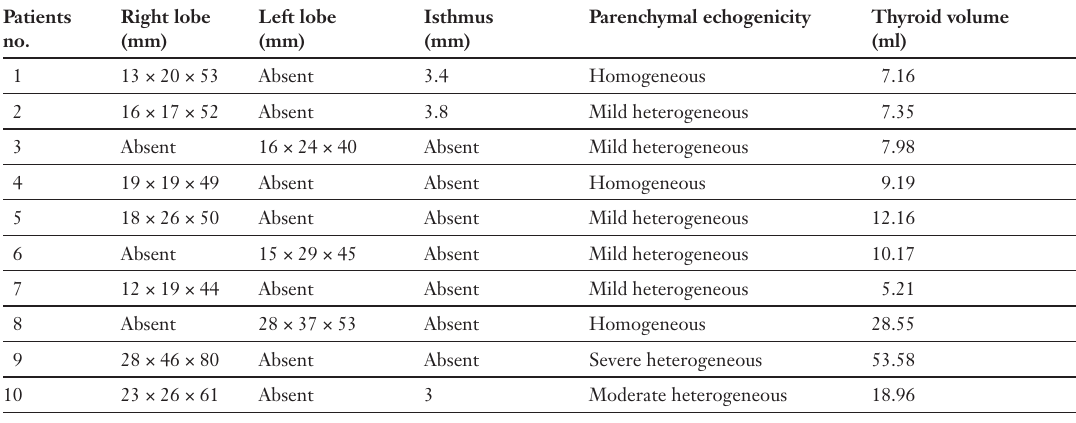
(transverse and longitudinal